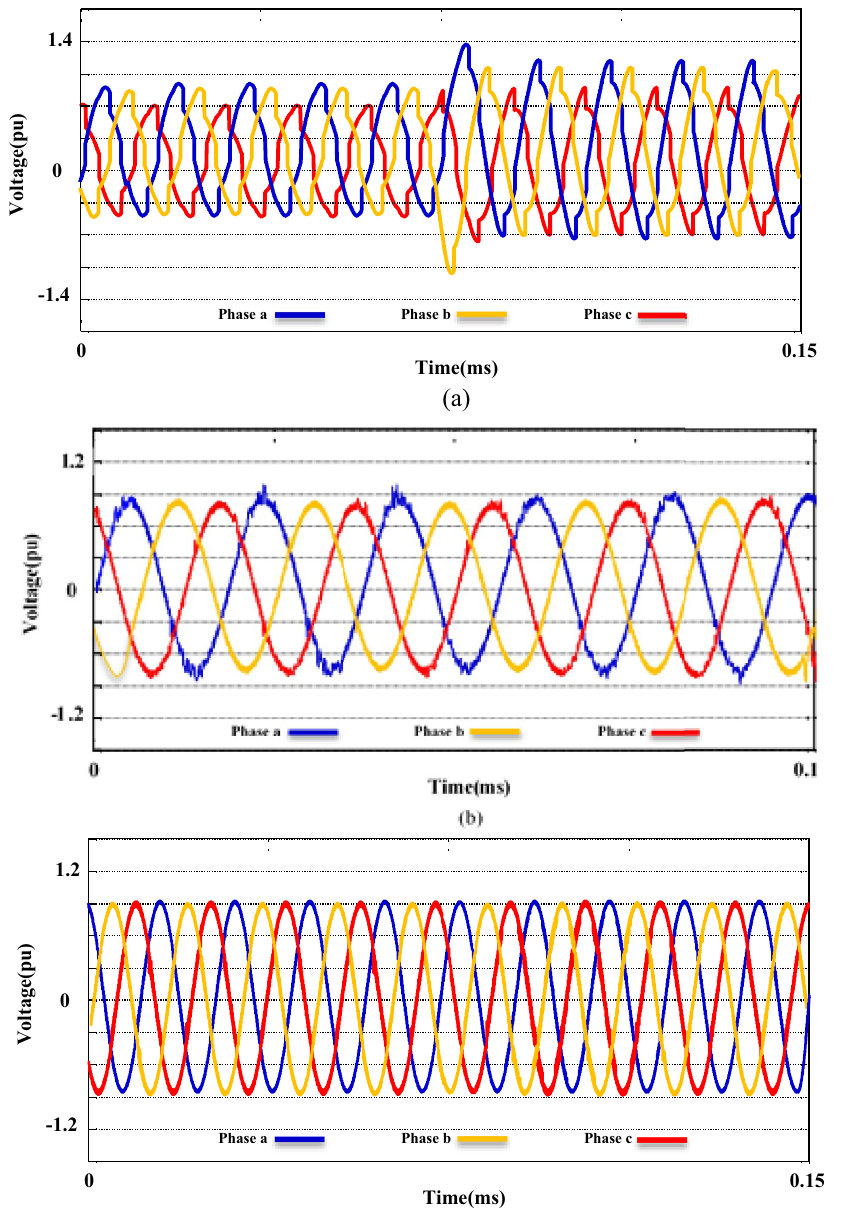
Figure 17. The voltage THD of the system; ( a ) without compensator devices, ( b ) with the UPQC module, ( c ) with the M-UPQC module.